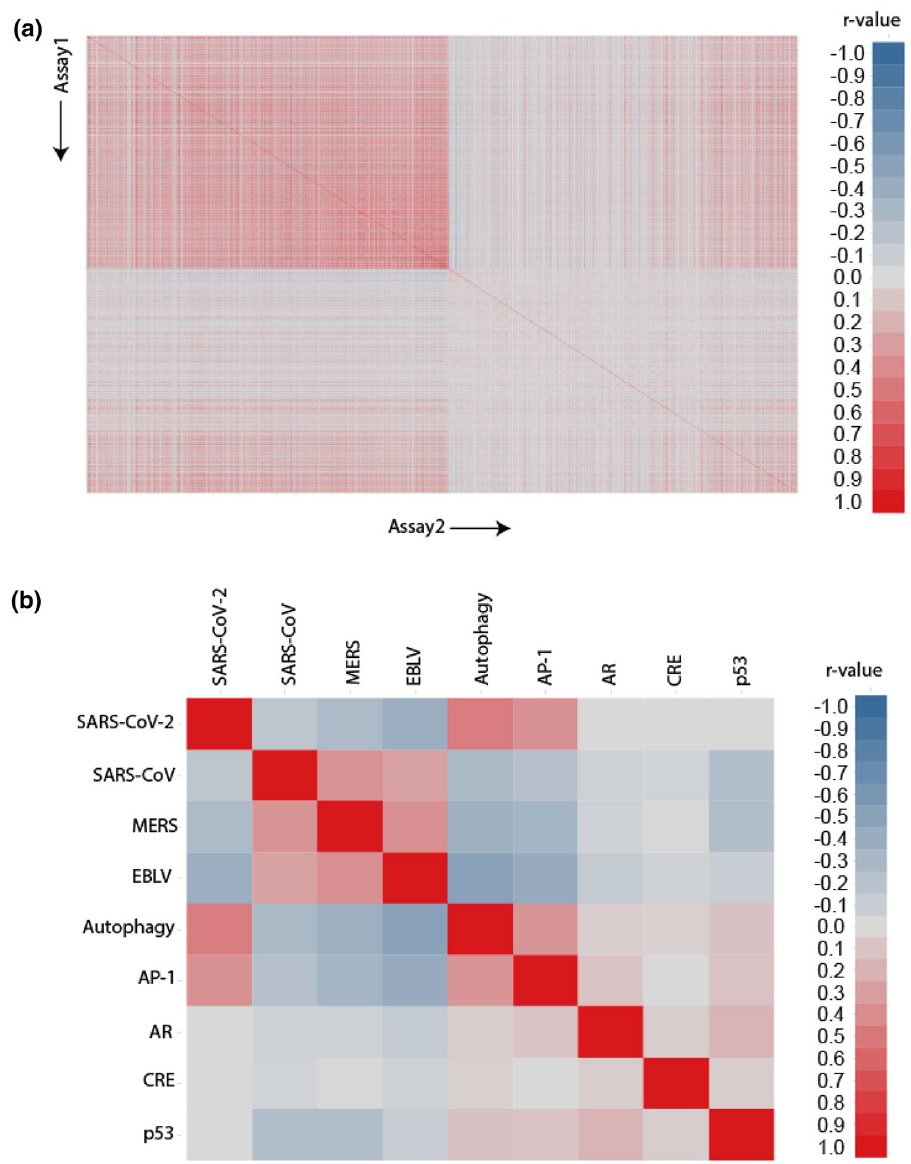
Figure 2. Activity profile correlations between the ~ 1000 NPC screens including the SARS-CoV-2 CPE assay. In the heat map, each row/column is a different assay. The heat map is colored by the correlation coefficient ( r ), such that darker shades of red indicate stronger positive correlations and darker shades of blue indicate stronger negative correlations. Gray means no correlation found. ( a ) Pair-wise correlations of all assays. ( b ) A zoomed-in view that shows the pair-wise correlations of example assays that either significantly correlated or showed no correlation with the SARS-CoV-2 CPE